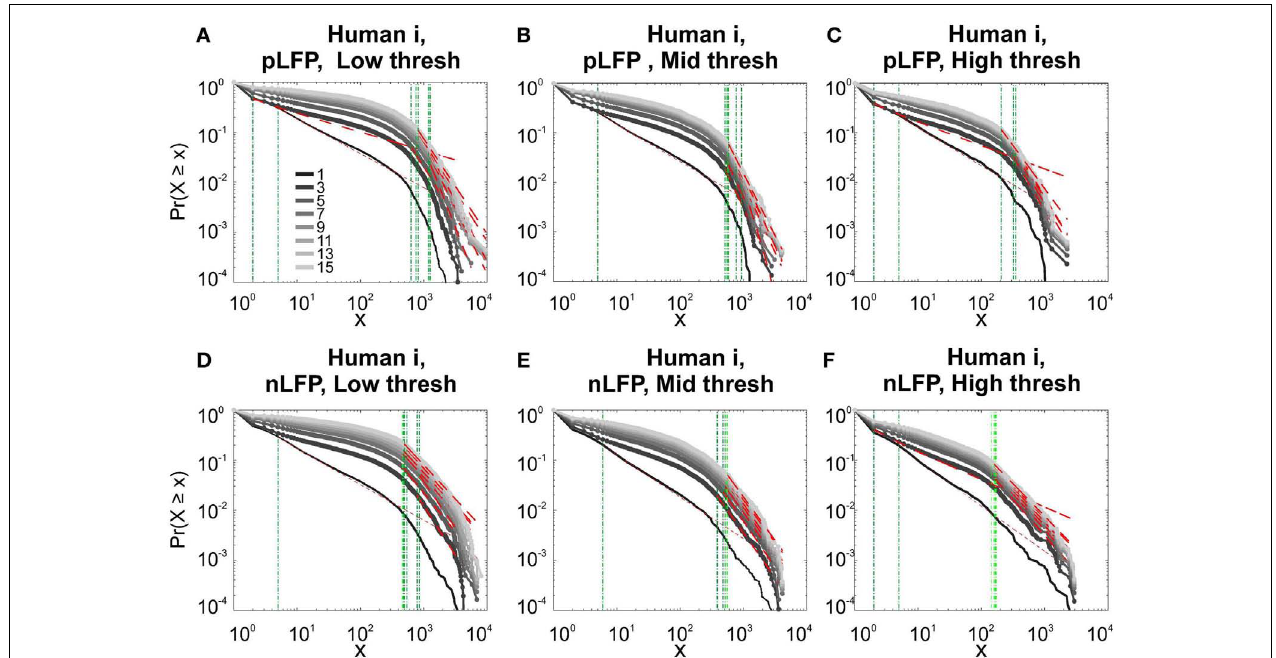
CDF, therefore negate power-law as the generating process.These curves show while nLFP has a closer relation with spiking, the avalanche dynamics of nLFP and pLFP are strikingly similar in their lack of robust criticality when tested with rigorous statistical tests.